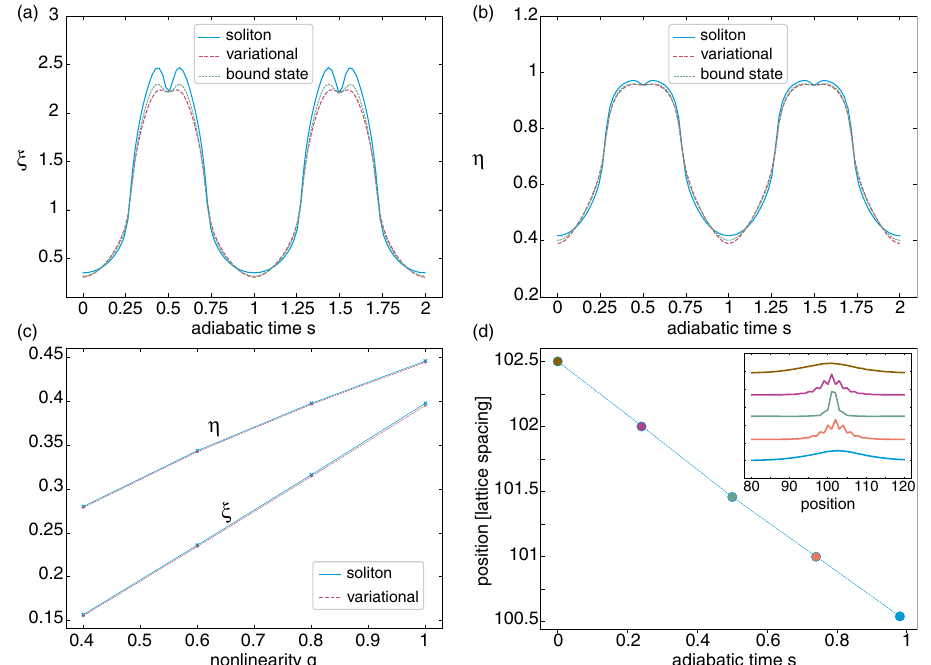
Fig.4|Characterizingsolitonevolutionduringtwopumpcycles.a Evolutionof the soliton ’ s width ξ inWannier space over two pumpcycles, asobtained by fi tting the numerical solution of Eq. (3) with a sech function (blue solid line). This is compared to the width of the variational-ansatz solution (dashed red line), and to that of the bound-state solution (green dotted line); here g = J 0 . b Same for the